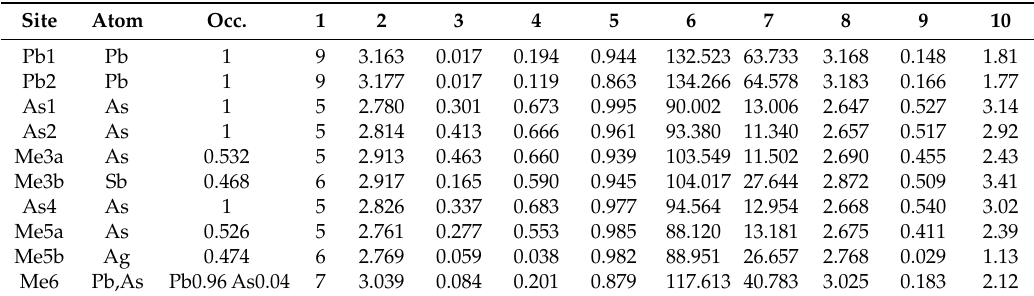
Table 11. Polyhedron characteristics for atoms in sample rath1.